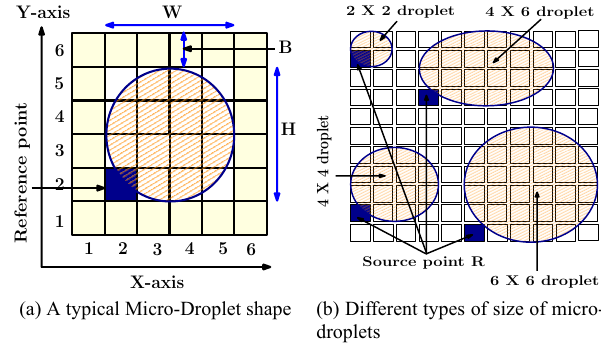
Fig. 4 Different types of shape and size of a droplet present on MEDA